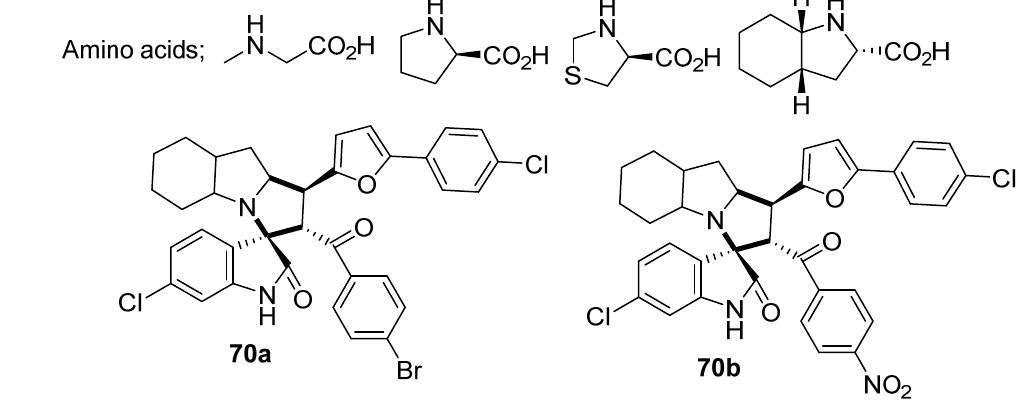
Scheme 18. Synthesis of spirooxindoles 70 .